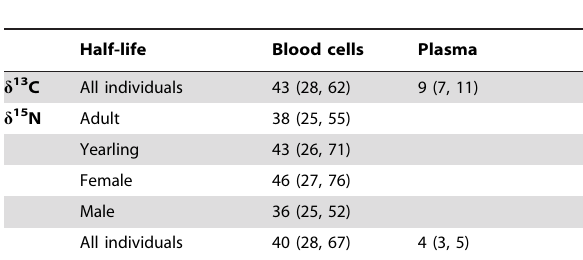
Table 2. Isotopic half-lives in arctic fox depending of the group (tissue, age, individuals) and the stable isotope ( d 13 C and d 15